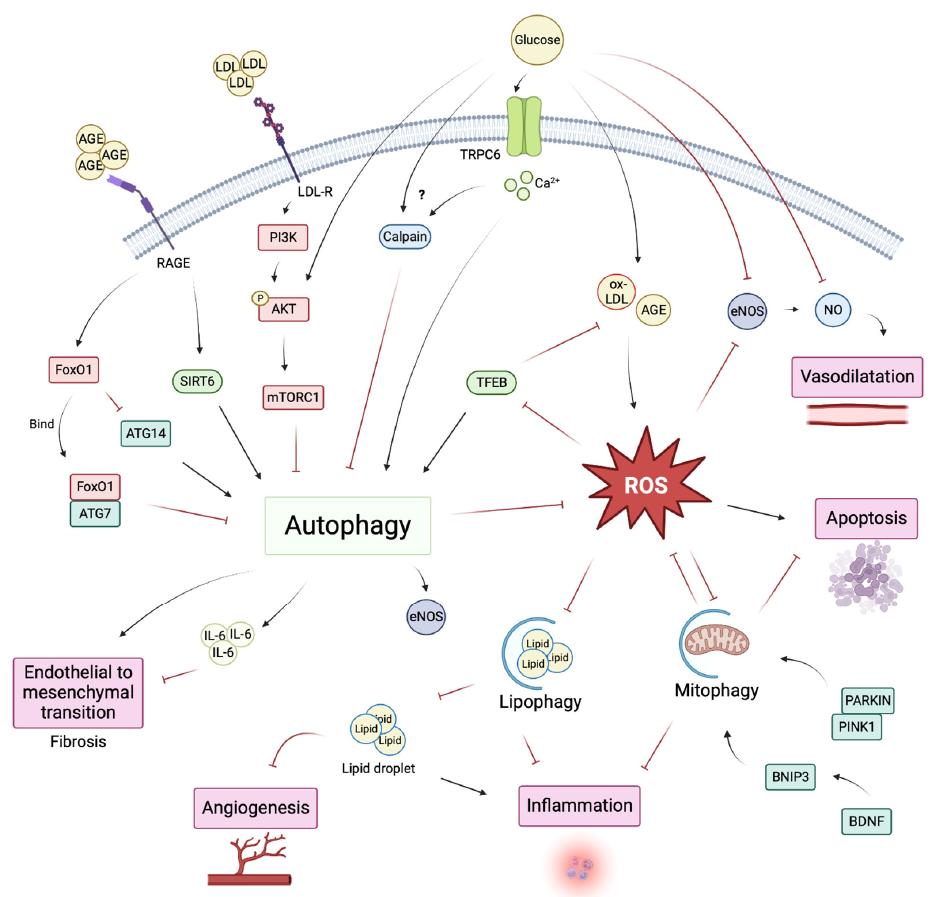
Figure 2. EC autophagy impairment in diabetes. The diabetic environment promote EC dysfunction that is linked to autophagy impairment. (Created with Biorender: https://biorender.com accessed on 10 January 2023).